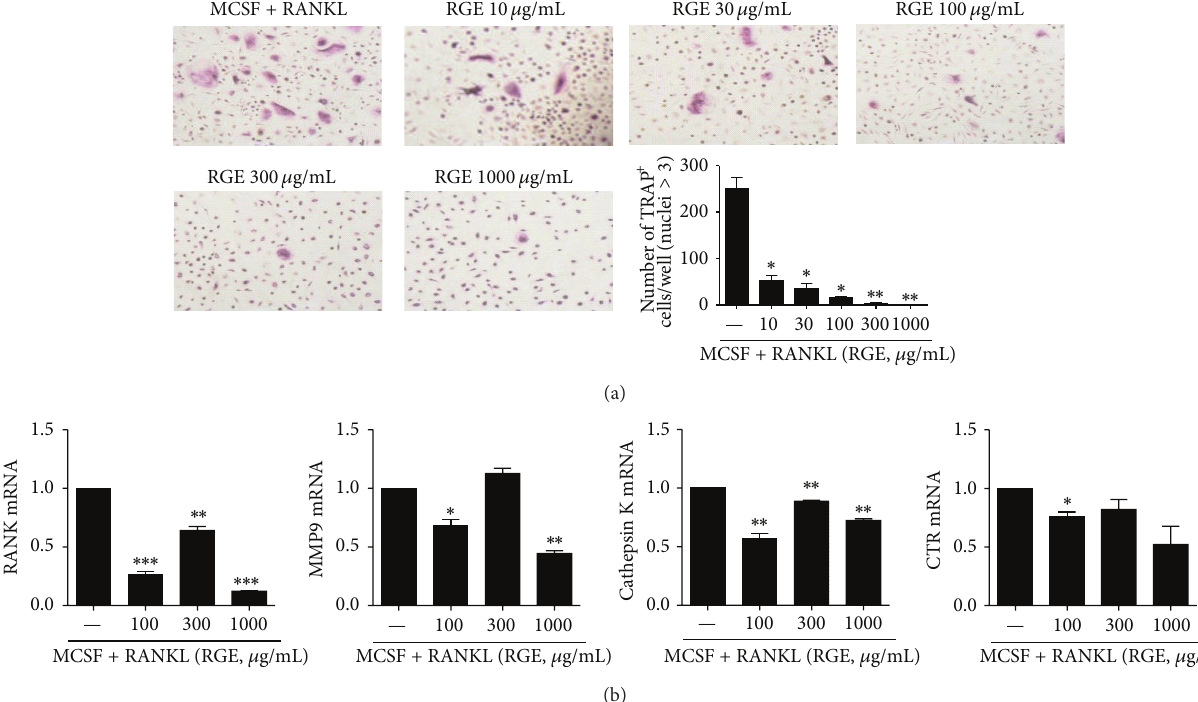
Figure 6: Red ginseng extract inhibits osteoclastogenesis in humans. Human peripheral blood mononuclear cells were cultured with M-CSF (10ng/mL) and RANKL (50ng/mL) in the presence or absence of various concentrations of RGE. (a) Cells were fixed and stained for TRAP (original magnification, × 100). The number of TRAP + cells was counted using light microscopy. The representative photographs from each groupareshown. (b)ThemRNAexpressionsofvarious osteoclastogenicmarkers suchasRANK, MMP9. CathepsinKand CTRwereanalyzed using real time PCR. BMM: bone-marrow-derived monocyte/macrophage; CTR: calcitonin receptor; MMP9: matrix metalloproteinase 9. Data are presented as the mean ± SD of three independent experiments ∗ 𝑃 < 0.05 , ∗∗ 𝑃 < 0.01 , and ∗∗∗ 𝑃 < 0.001 compared to